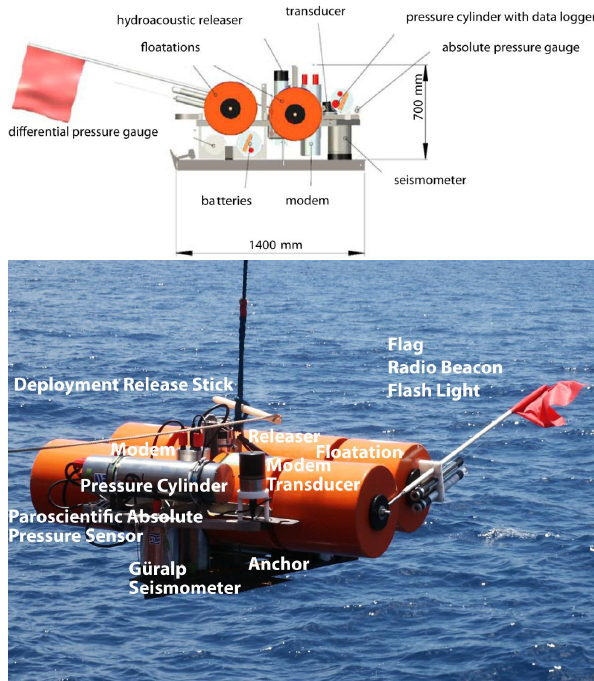
Fig. 20. Sketch and photo showing the OBU just before deploy-